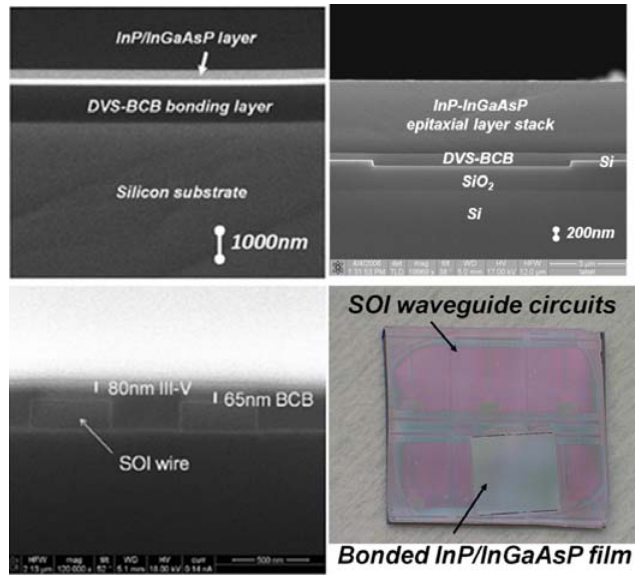
Figure 8. SEM cross-section images of transferred III-V layer stacks and a top-down view.